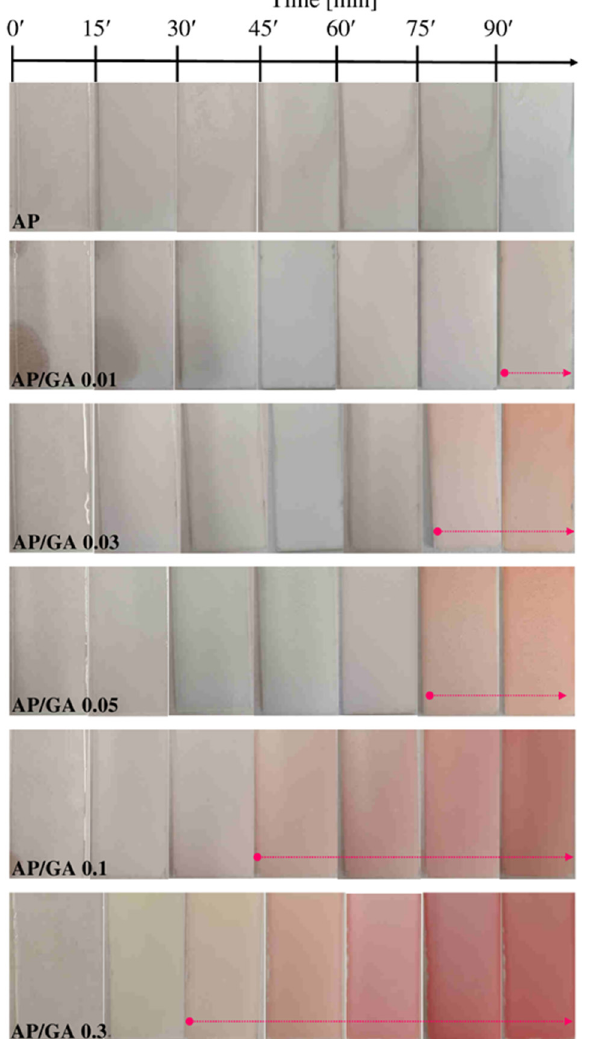
Figure 2. Photographs of the AP and the AP/GA coatings deposited on glass, taken every 15 min from the mixing of the two components .